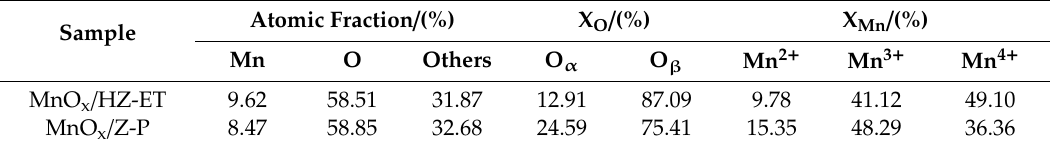
Figure 5. XPS spectra of Mn 2p ( a ), O 1s ( b ) of the catalysts. Table 3. Surface atomic concentrations and relative concentration ratios of Mn and O.